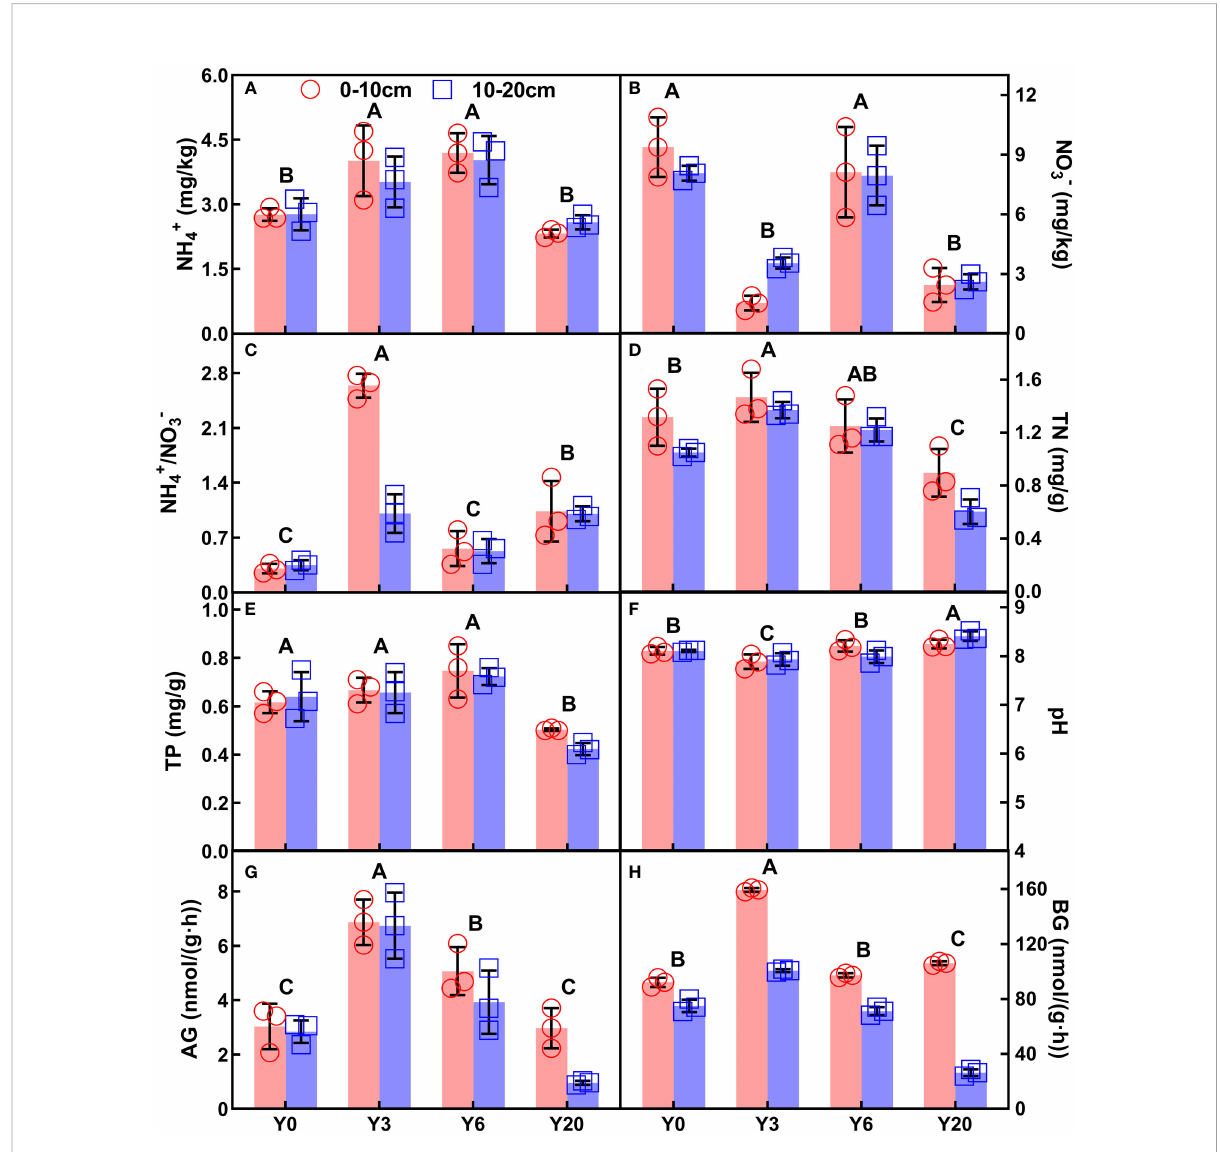
FIGURE 1 NH 4+ (A) , NO 3- (B) , the ration of NH 4+ to NO 3- (NH 4+ /NO 3- , C ), TN (D) , TP (E) , pH (F) , AG (G) , and BG (H) (Mean ±SD) of different soil depths (0- 10 cm and 10-20 cm) along the chronosequence of mugwort cropping. Y0: continuous maize-wheat rotation; Y3: mugwort cropping for 3 years (since 2017); Y6: mugwort cropping for 6 years (since 2014); Y20: mugwort cropping for 20 years. Different letters indicate signi fi cant differences among the four cropping years at P < 0.05. See Table 1 for